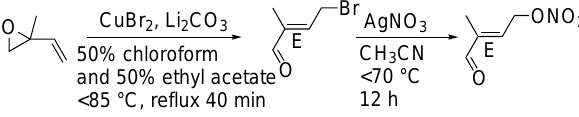
Figure 2. The synthesis route for the 4,1-isoprene nitrooxy